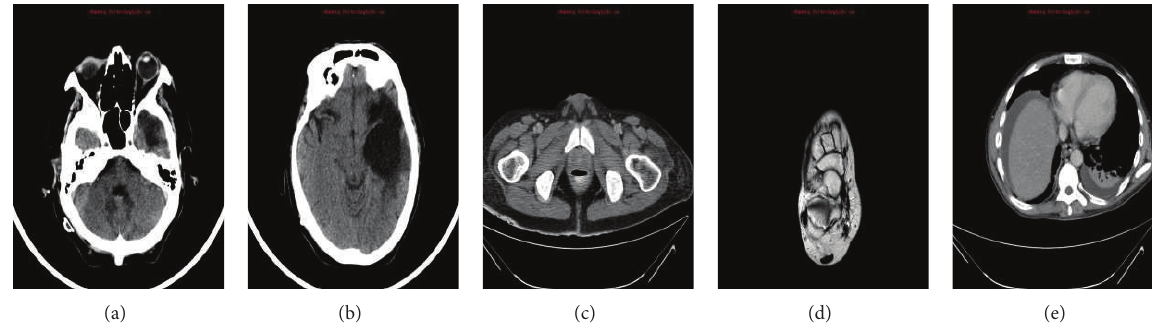
Figure 2: Original image samples Q1, Q2, Q3, Q4, and Q5. Simulation results: image type: medical image; file type: TIFF; test sample: Q1;